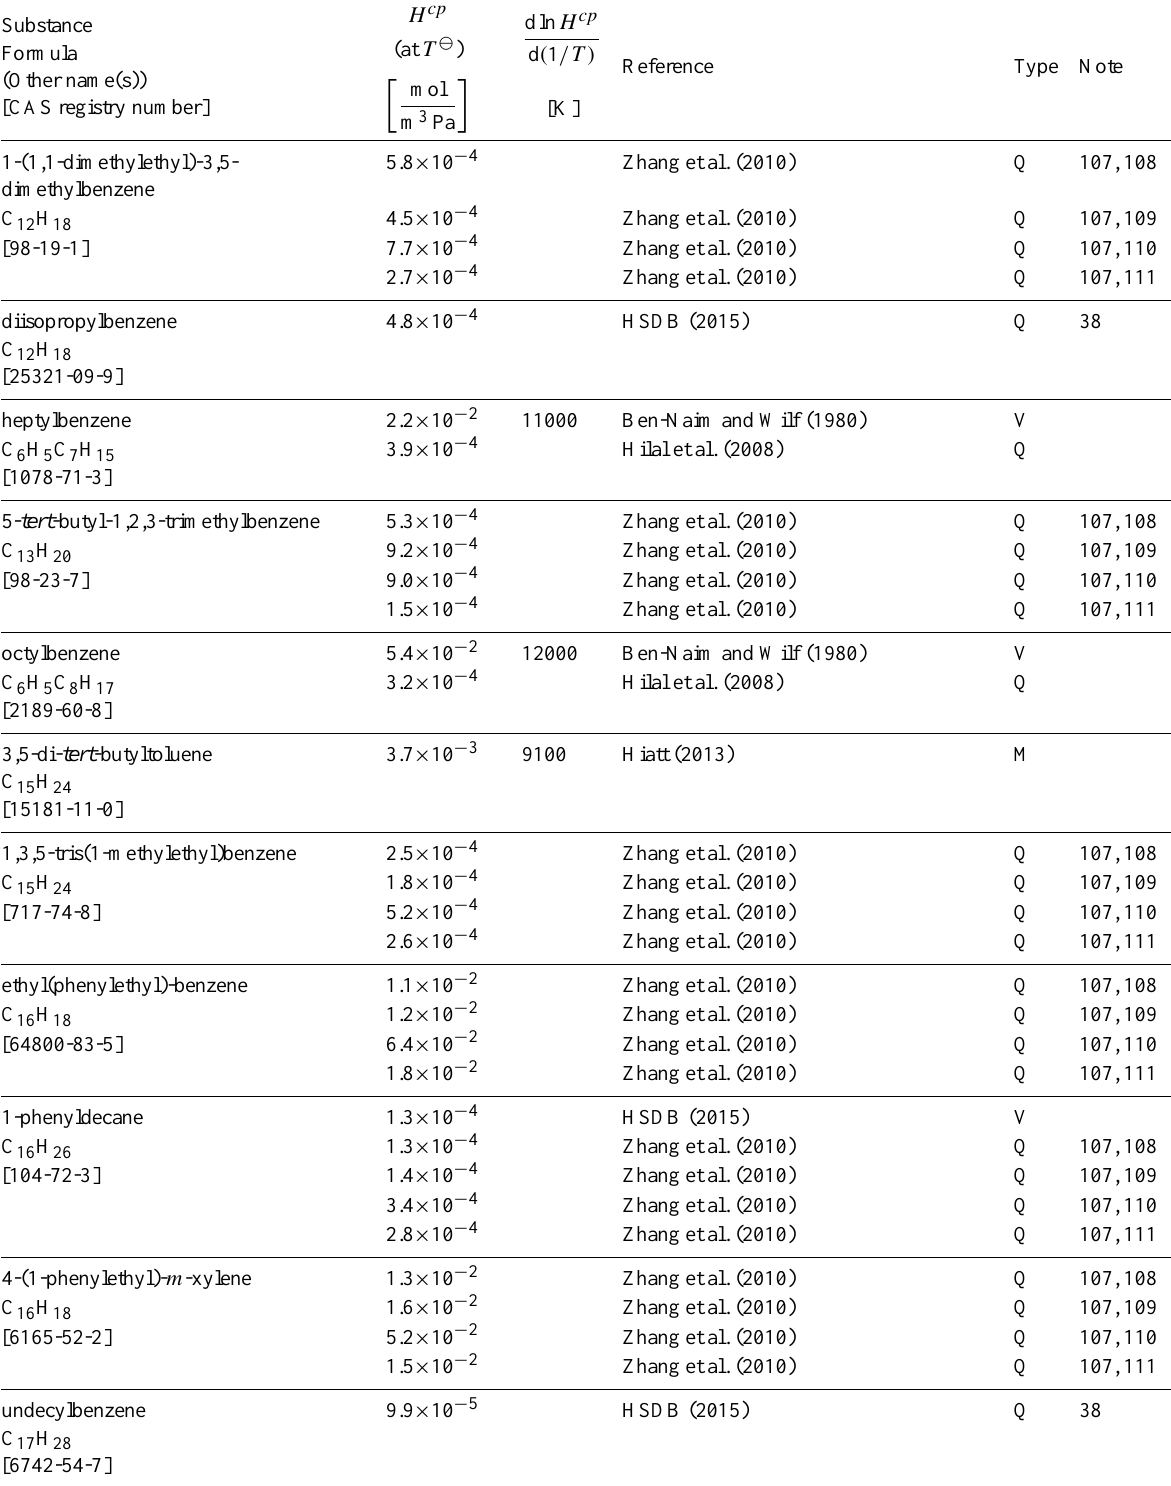
Table 6: Henry’s law constants for water as solvent